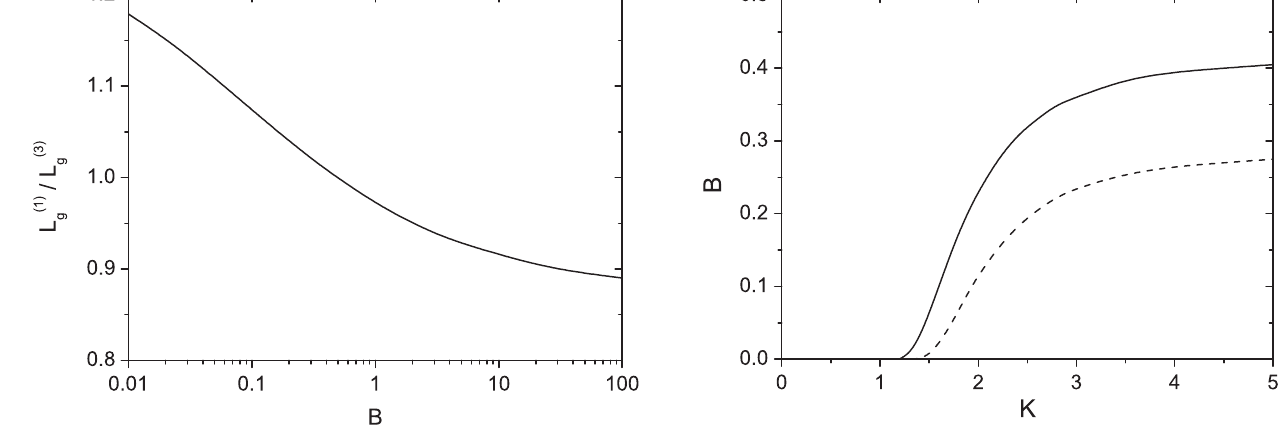
FIG. 4. Ratio of gain lengths for lasing at the fundamental wavelength and at the third harmonic versus diffraction parame- ter of the fundamental wavelength for large values of the undulator parameter K .